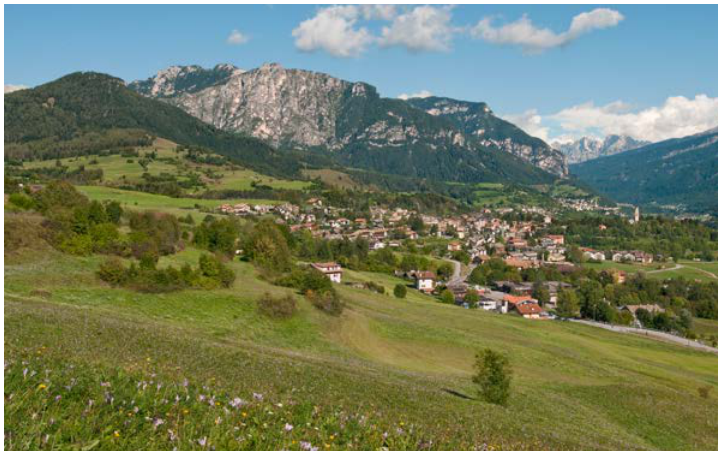
Figure 1 – Mount Cornón in the Fiemme Valley. Photo by Laura Gasperi. Courtesy of Museo degli Usi e Costumi della Gente Trentina